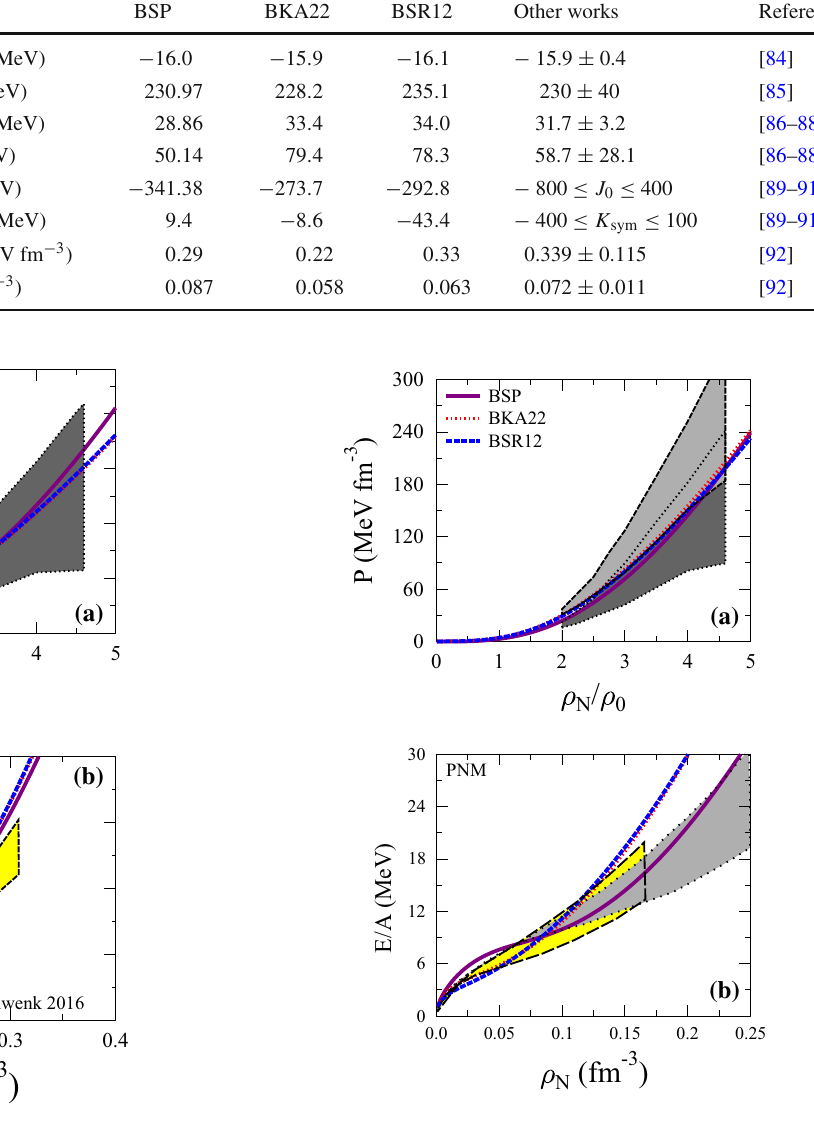
Fig. 2 Similar to Fig. 1 but for PNM. The shaded areas in a are the results extracted from heavy-ion experimental data [96], while the yel- low shaded area in b is the theoretical binding energy for PNM at low densities obtained from the chiral effective field theory calcula- tions [102,103] parameter sets, the SNM and PNM EOS stiffnesses predicted by BSP parameter set are relatively similar. Only at relatively high density ( ρ N > 4 ρ 0 ), SNM EOS of BSP becomes stiffer than those of BKA22 and BSR12. We also compare the bind- ing energy predicted by the BSP parameter with the recent results obtained by the authors of Refs. [84,98]. It is also evi- dent that the BSP result is also compatible with their results. Furthermore, in SNM binding energy constraint in Fig. 1 we also use SNM binding energy around the saturation density data, which is extracted from simple Bethe–Weizäcker